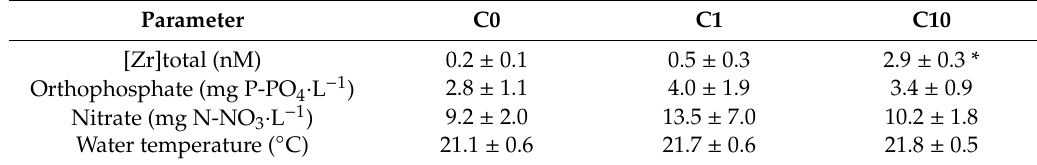
Table 1. Physicochemical parameters (mean ± standard error; n = 3) in the C0, C1, and C10 exposure conditions during the 4 weeks of exposure. A two-way ANOVA was performed to detect significant di ff erences between exposure times, and these di ff erences are indicated by * ( p < 0.05; n = 3).